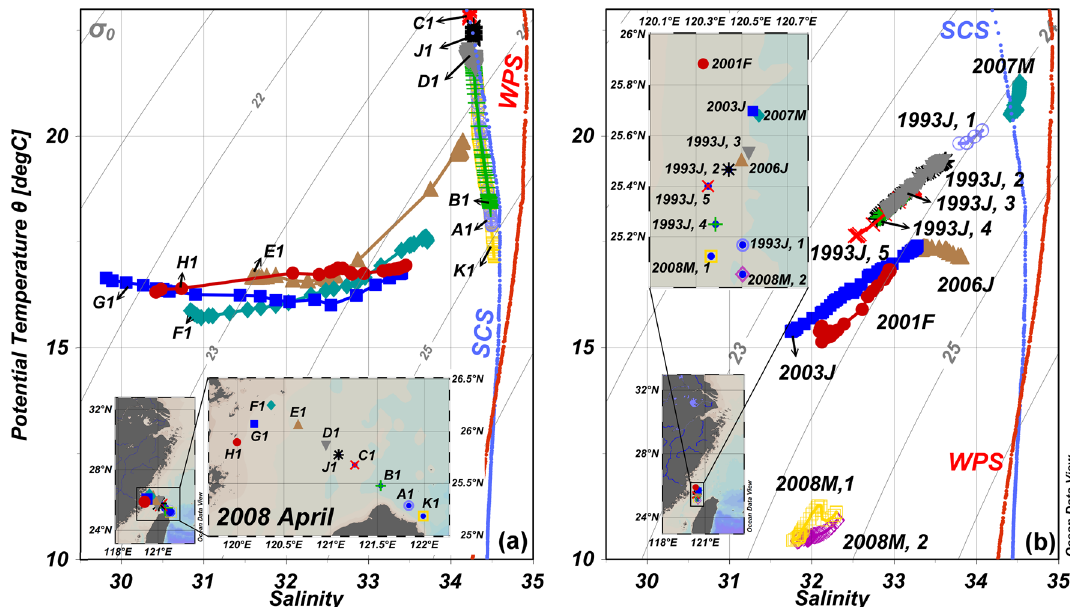
Figure 3. The θ/S plots for the stations in the southwestern East China Sea: ( a ) ORI-861 data and ( b ) various other winter and spring data near Stn. E1 of the ORI-861 cruise (Station is identified by year and month: e.g., 2007 M denotes March, 2007; map generated by Ocean Data View version 5.2.1.; https upwelled off northeastern Taiwan, peaking at Stn. K1 or just east of it. Subsequently, the upwelled waters down- welled towards the west, then upwelled again or became mixed vertically near Stns. J1 and D1. Such a pattern has been reported in the study area in summer 38 , but not in other seasons until recently 39 . As a result, the θ/S pattern for Stns. J1 and D1 falls on the same θ/S line as Stns. C1, B1, A1, and K1. This is the same pattern as Stns. A2–G2 found in the southern transect 25 (Fig. 2e–h). Important to point out is that the western side of the Kuroshio is comprised of the outflow from the SCS 40–42 . As a result, whether waters at Stns. J1 and C1 are from the southern Taiwan Strait or are from a branch of the Kuroshio which has circumvented the northern tip of Taiwan, the θ/S patterns are indistinguishable. Of note is that the high density (σ t > 25) water found at the bottom of the easternmost station in the northern transect (Fig. 2c) is much higher than any in the southern transect (Fig. 2g). This is another proof that the high-density water comes from the Kuroshio after circumventing the northern tip of Taiwan. Having said the above, however, albeit the shipboard data collected in April reflect the history of the waters found at the time, it is a snapshot nonetheless. Here we look at consecutive satellite images to help to elucidate the flow patterns before our cruise. Figure 4a–j shows the mean satellite SST in the vicinity of the study area. It was still relatively warm in Oct. 2007 (Fig. 4e) but the ECS was already generally cooler than the SCS and the coastal region off China was gener- ally cooler than offshore areas, especially compared with the Kuroshio region. By Dec. 2007, the temperature in the southwestern East China Sea and most of the Taiwan Strait was relatively cool compared with the SCS and the Kuroshio region (Fig. 4f). A branch of the Kuroshio and the SCS water occupied the southeastern Taiwan Strait but waters cooler than 20 °C, evidently from the north, seemed to have pushed the warmer waters to as far south as Penghu Is. in the southeastern Taiwan Strait. The wind-induced blocking of these warm waters relaxed in late spring, and by April 2008 the warm waters again flew through the eastern Taiwan Strait (Fig. 4h). Fig- ure 4c,i shows that warm waters extended farther north in Feb. 2007 and Feb. 2009 during non-La Niña years. During the La Niña Feb. of 2008, however, cool waters west of Penghu Is. extended farther southward along the coast of China (Fig. 4g). Note waters with temperatures in the lower teens reached the southwestern Taiwan Strait by this time. With cold waters occupying almost the entire Taiwan Strait, the northward movement of the Kuroshio branch and the SCS water was halted, and warm waters were confined to only a small area southeast of the Taiwan Strait. The wind-induced blocking of these warm waters relaxed in late spring, and by April 2008 the warm waters again flew through the eastern Taiwan Strait (Fig. 4h). By Feb. 2008 seawaters with temperatures in the teens have moved further southwestward along the coast of China. Part of the cold water seemed to have turned toward Taiwan near Pingtan Is. and occupied the entire northern Taiwan Strait. Satellite images indicate that Feb. is the coldest month in the Taiwan Strait. No warm Kuroshio or SCS waters are evident in the Taiwan Strait except off southwestern Taiwan (Fig. 4g). Indeed, the La Niña Feb. of 2008 was exceptionally cold when tons of fish were killed by the cold water around Penghu Is. 43–45 . Cross-strait front and eastward flow of the cold CDW in winter/spring are known to occur 20,46,47 but it was rare that the cold water reached Penghu Is. By April 2008 warmer waters have already flowed from the northern SCS to the ECS through the Taiwan Strait (Fig. 4h). Cold waters along the coast of China have by now also been pushed back northward. Waters with temperatures in the low teens have now largely retreated to the coast north of 26° N and Stns. H1, G1, F1, and E1 recorded temperatures around 16, 17 °C (Fig. 2a).